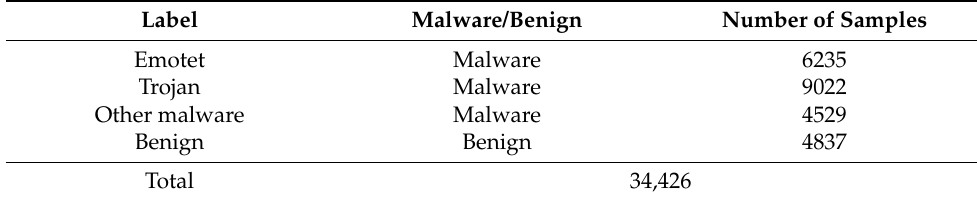
Table 5. Summary of malware data in Dataset